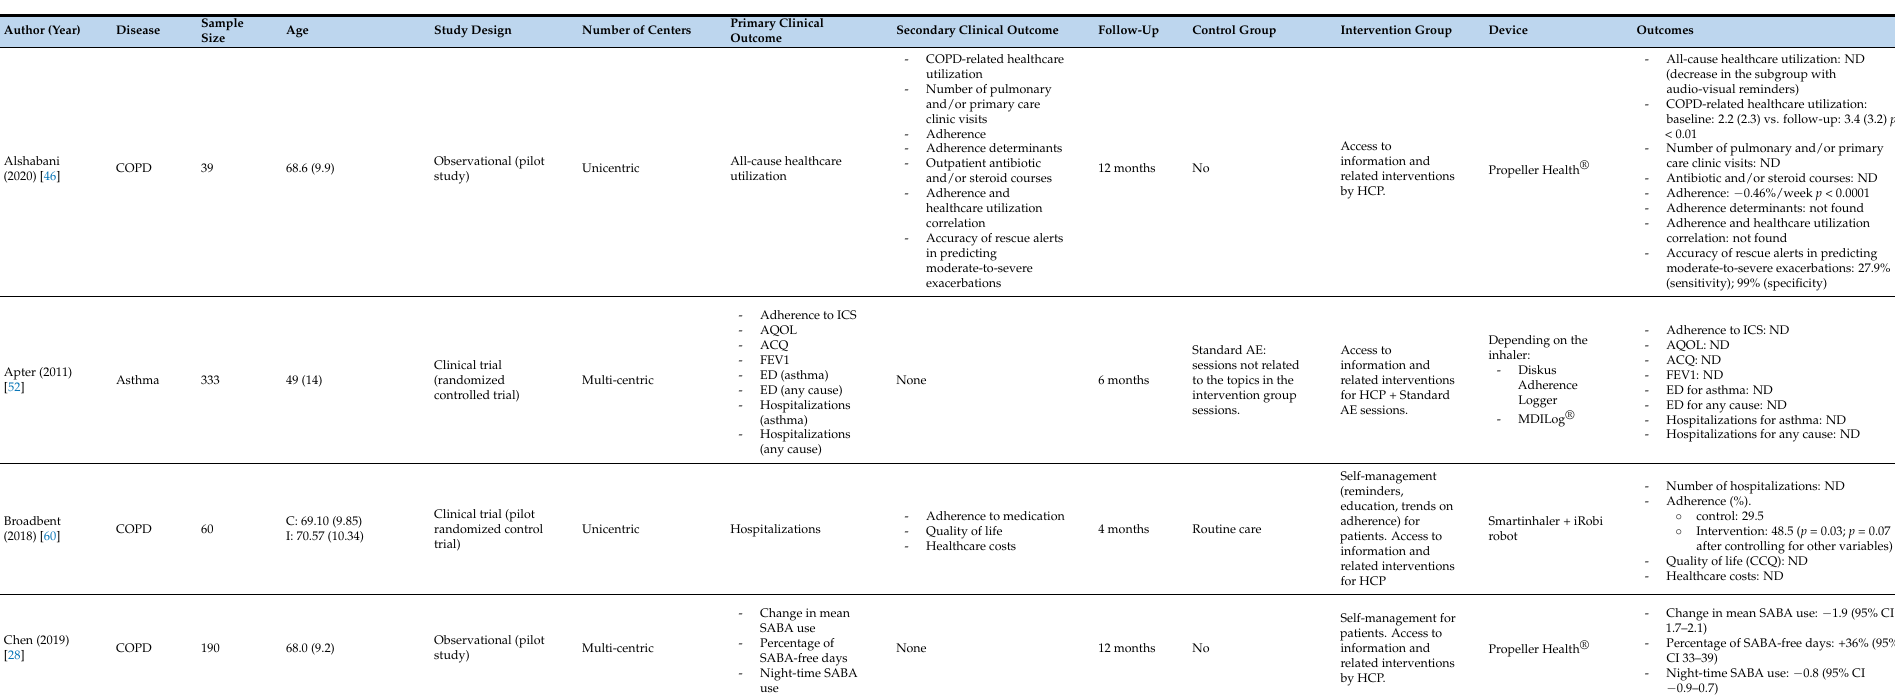
Table 1. Summary of results. ACQ (Asthma Control Questionnaire); ACT (Asthma Control Test); AQLQ (Asthma Quality of Life Questionnaire); Asthma-related quality of life (AQOL); AE (asthma education); C (Control group); CAT (COPD assessment test); CI (confidence interval); CCQ (Clinical COPD questionnaire); COPD (chronic obstructive pulmonary disease); DPI (dry-powder inhaler); ED (Emergency Department); FeNO (Fractional Exhaled nitric oxide); FEV1 (forced expiratory volume in 1 s); HCP (healthcare professionals); I (intervention group); ICS (inhaled corticosteroid); NA (not available); ND (no difference); PEF (peak expiratory flow); pMDI (pressurised Metered Dose Inhaler); POEMS (Polymedication Electronic Monitoring System); SABA (short acting beta agonist); SGRQ (St. George’s Respiratory